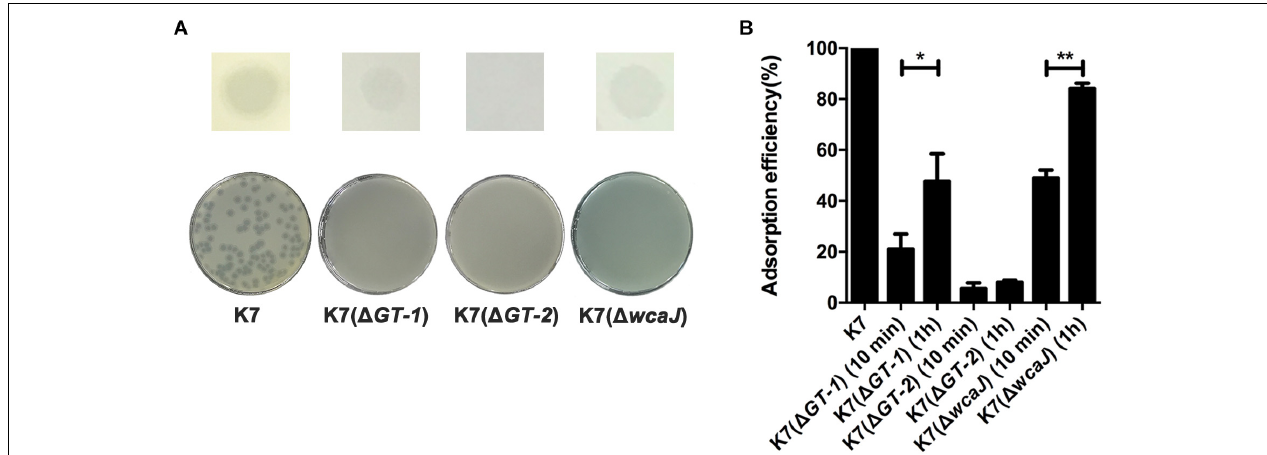
FIGURE 5 | Sensitivity of K. pneumoniae K7( (cid:49) GT-1 ), K7( (cid:49) GT-2 ), and K7( (cid:49) wcaJ ) to GH-K3. (A) Spot and plaque forming assays. Five µ l of GH-K3 solutions were spotted onto freshly seeded lawns of K. pneumoniae K7( (cid:49) GT-1 ), K7( (cid:49) GT-2 ), and K7( (cid:49) wcaJ ) for 6 h at 37 ◦ C before observation (top). Meanwhile, the sensitivity of K. pneumoniae K7( (cid:49) GT-1 ), K7( (cid:49) GT-2 ), and K7( (cid:49) wcaJ ) to GH-K3 were determined by plaque assays (bottom). K7 was used as a control. (B) Adsorption efficiency. The adsorption efficiency of GH-K3 binding to K. pneumoniae K7( (cid:49) GT-1 ), K7( (cid:49) GT-2 ), and K7( (cid:49) wcaJ ) were determined. ∗ and ∗∗ significant differences at P < 0.05 and P < 0.01, respectively. Data represent the mean ± SEM of triplicate